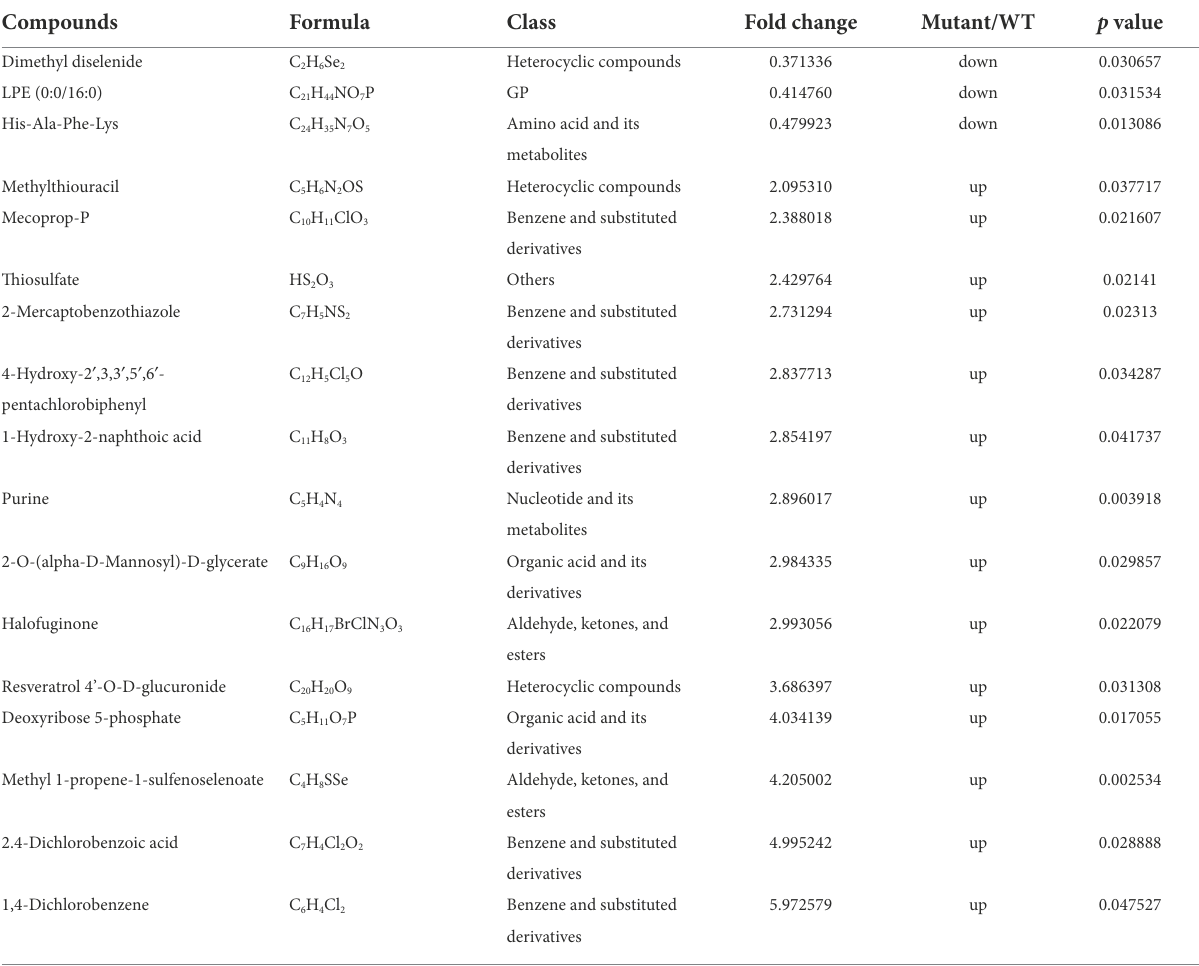
TABLE 1 Metabolic differences between wild type Burkholderia arboris and ∆